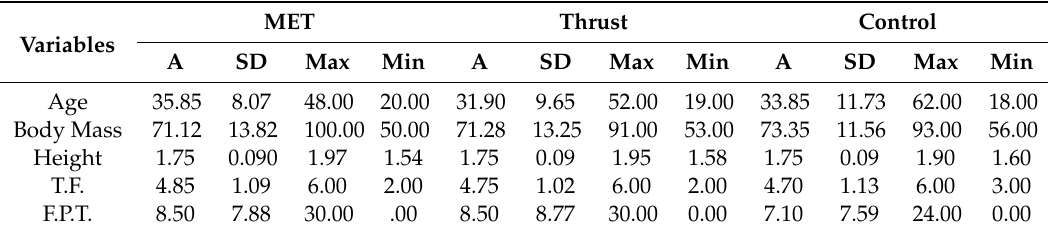
Table 1. Descriptive table of continuous variables per group.